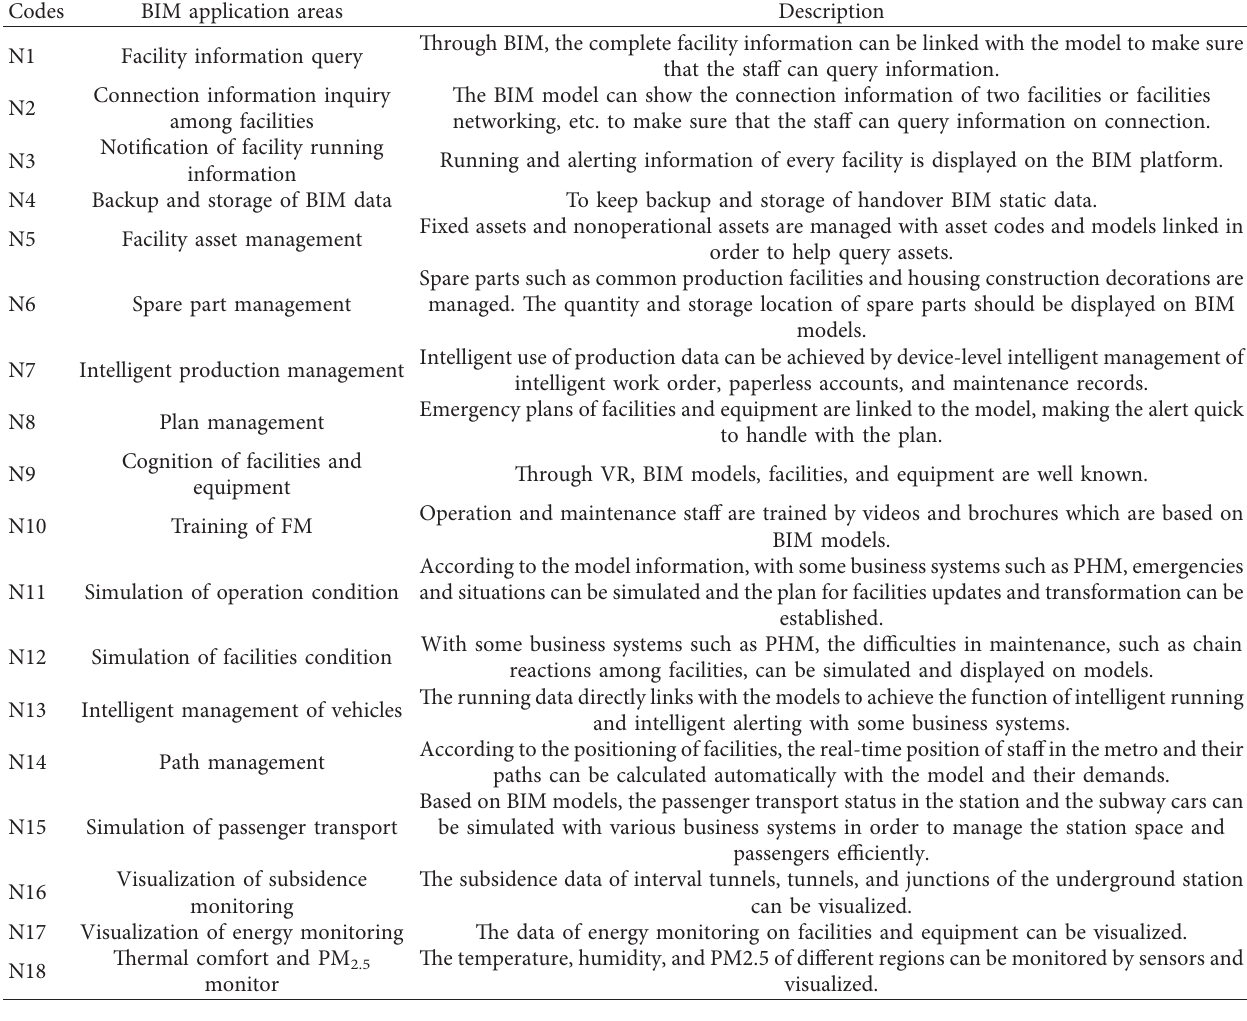
Table 2: Summary of BIM application areas for FM in urban rail transit.